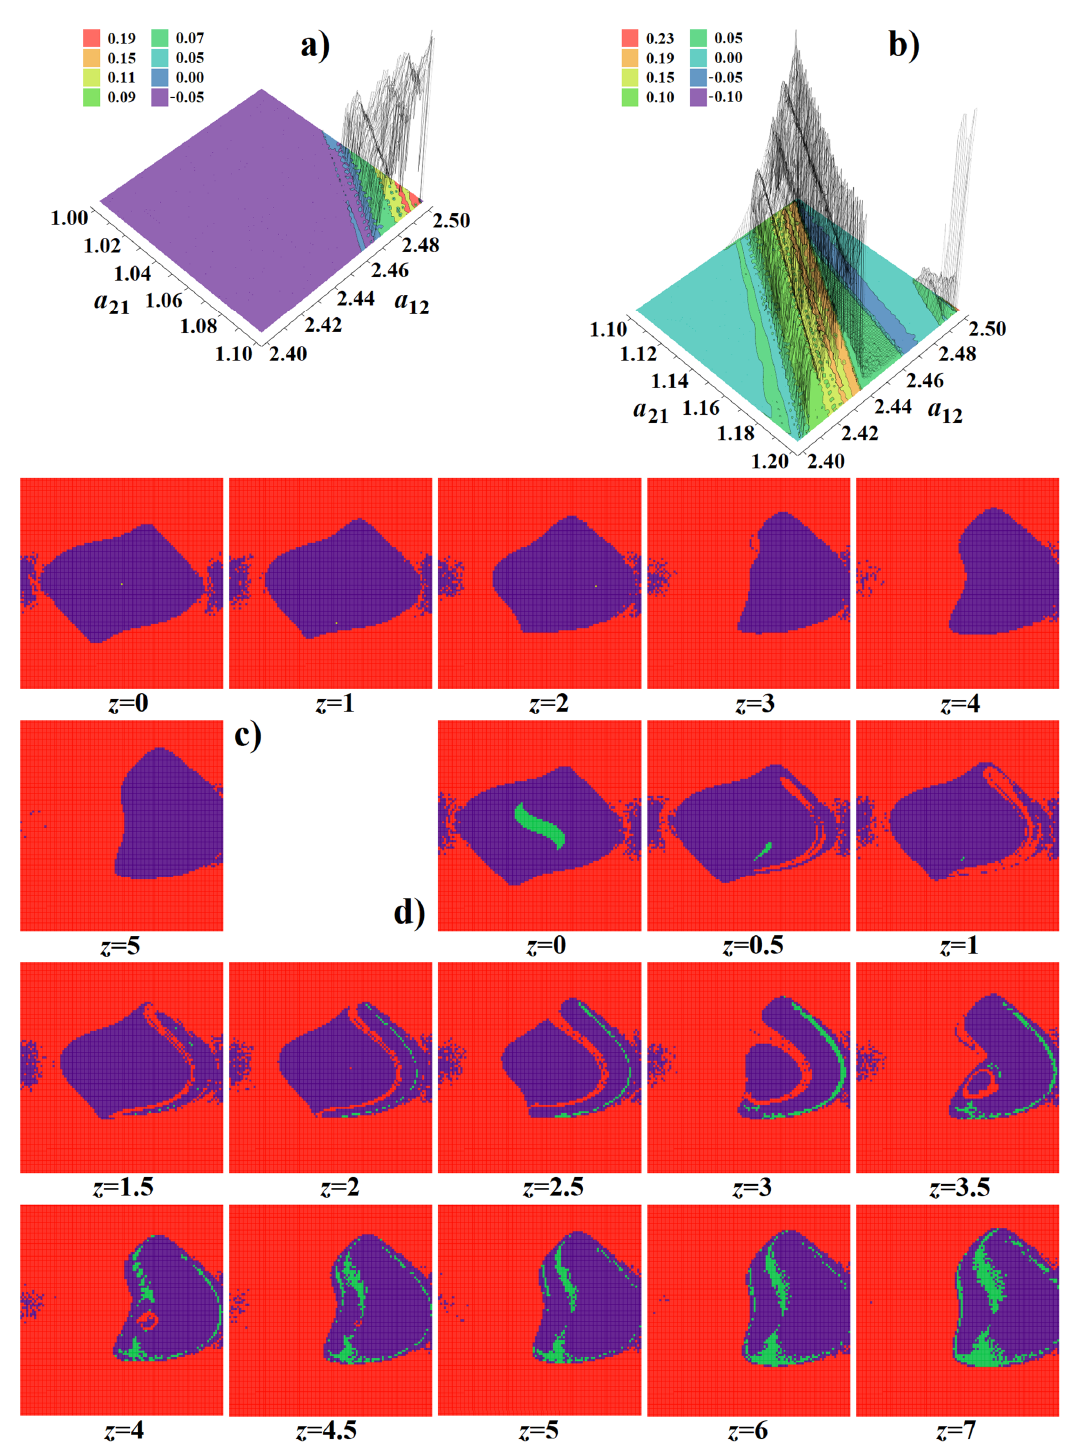
Figure 5. Selected numerical results associated with third order chaotic system: ( a , b ) rainbow-scaled contour plots of largest Lyapunov exponent (LLE) as two-dimensional functions of the internal parameters of chaotic oscillator, parameter step 0.001, graph contains 10,201 points. Colored basins of attraction for ranges of state variables x (−5, 5) and y (−5, 5), chaotic solution (red), unbounded solution (red), fixed point (green): ( c ) dynamical system Equation (1) with parameter group Equation (8), ( d ) dynamical system Equation (1) having parameter set Equation (8).